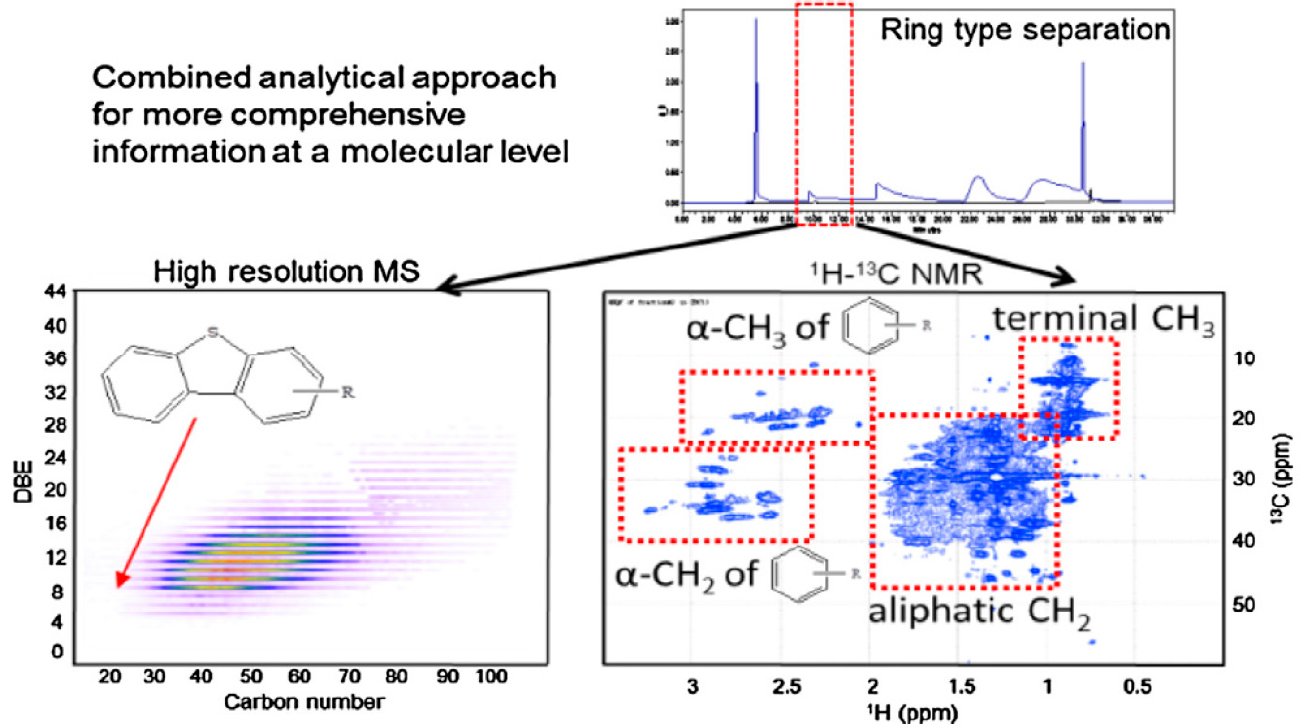
Figure 9. Combined analytical approach proposed by Kim et al. [238]. (Adapted with permission from Ref. [238] Copyright 2017, copyright Elsevier).